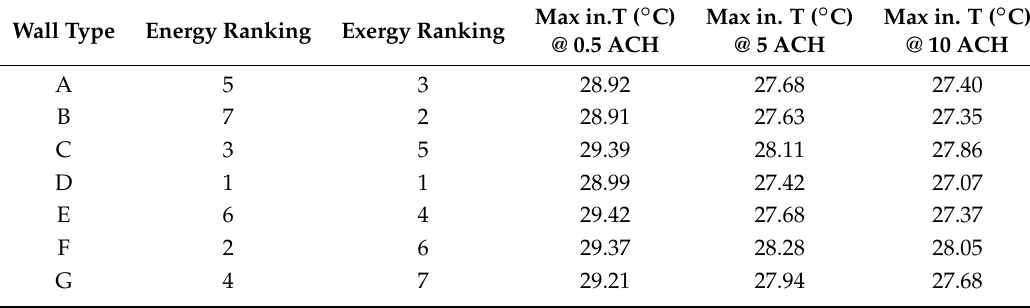
Table 4. Summary of the